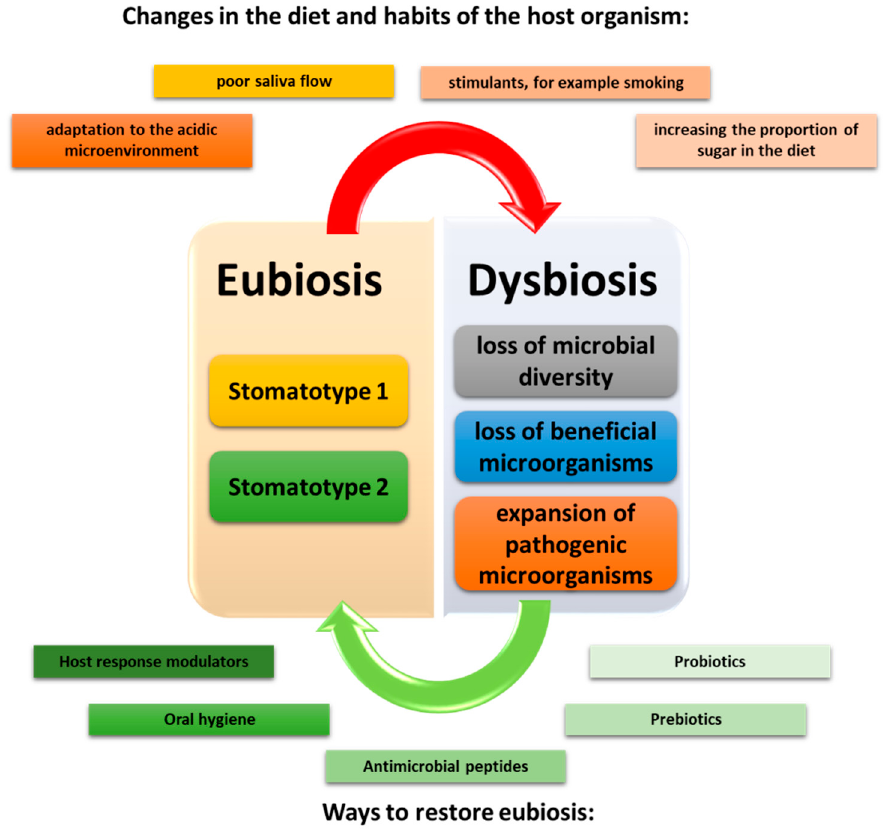
Figure 4. Disorders leading to the formation of dysbiosis of oral microorganisms, taking into account factors contributing to the restoration of eubiosis (based on [26,38]).